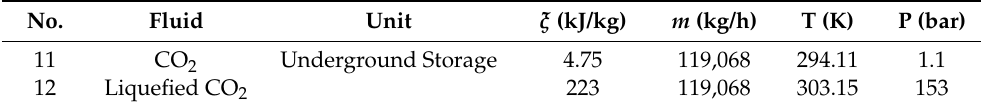
Table 8. Thermodynamic properties of selected stream materials. No.